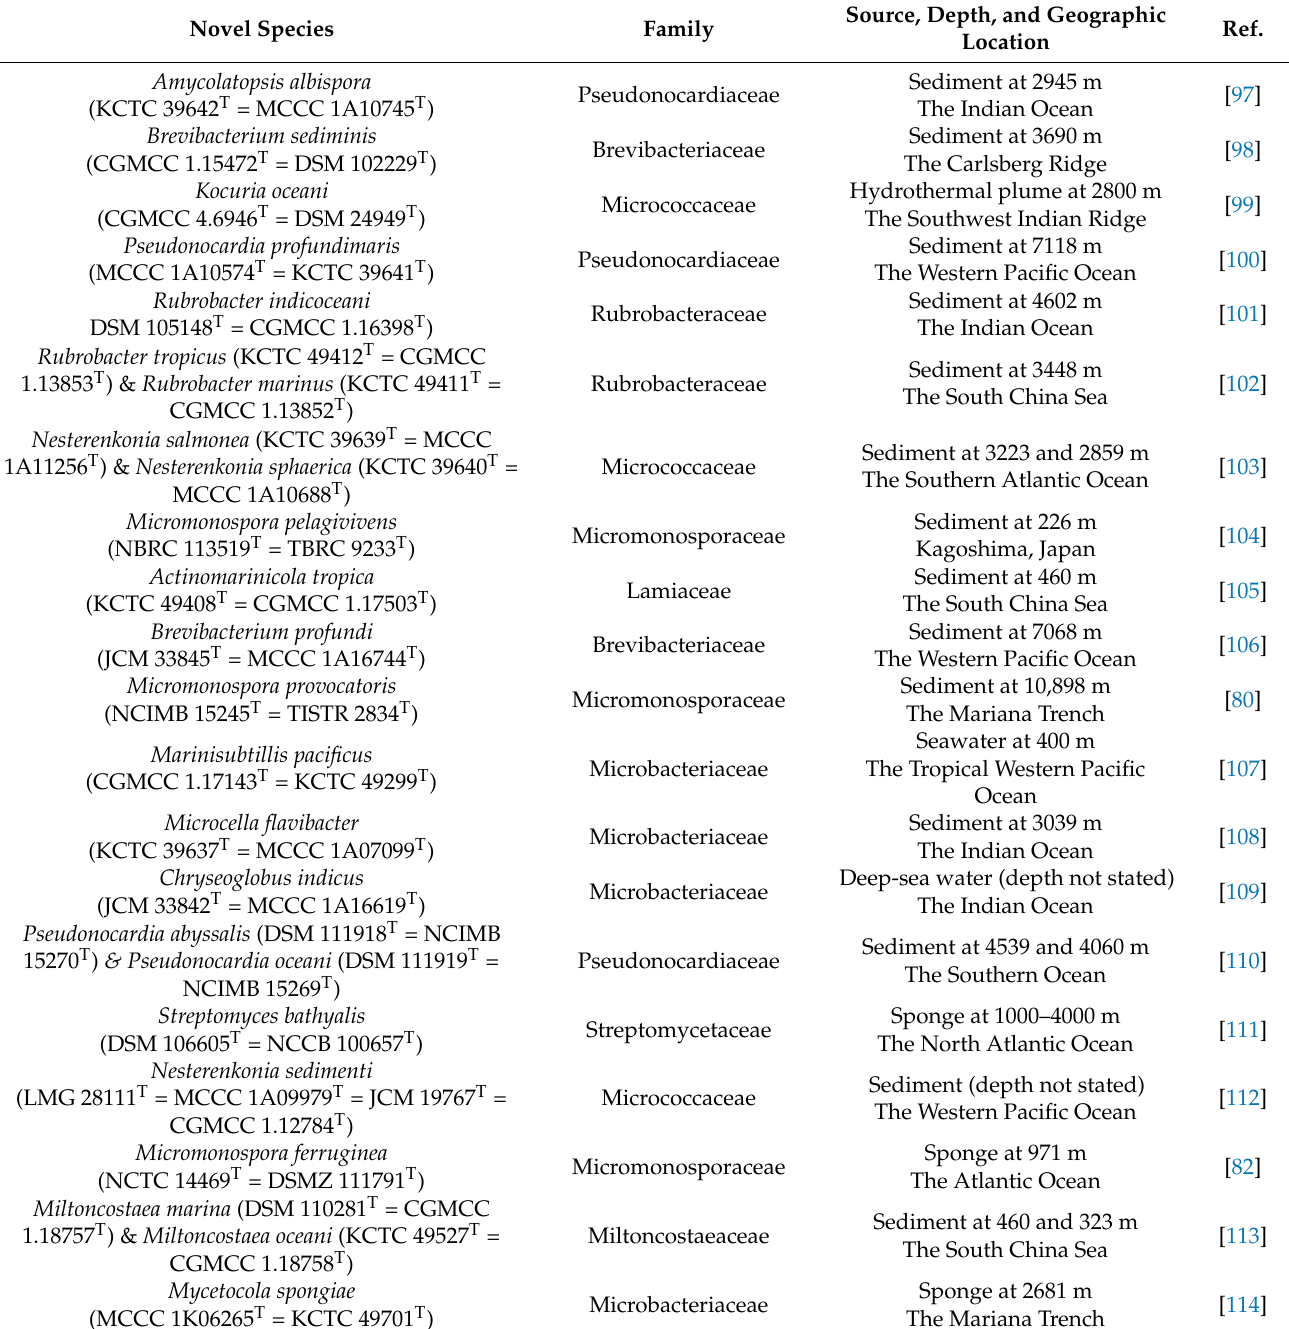
Table 1. New species of actinobacteria from deep-sea niches reported between 2016 and 2022. Superscript T designates type